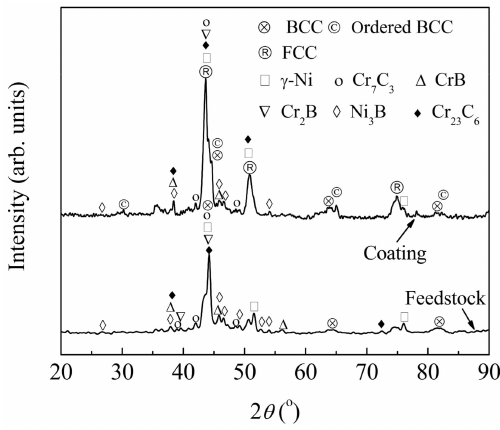
Figure 3. X-ray diffraction (XRD) patterns of feedstock and HEA/Ni60